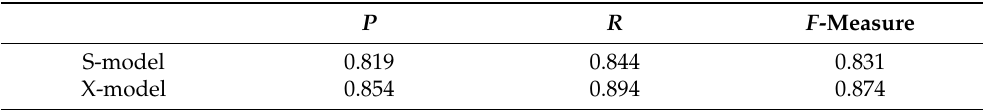
Table 1. Mean values of precision, recall, and F -measure for 3-fold cross-validation with the YOLOv5 S- and